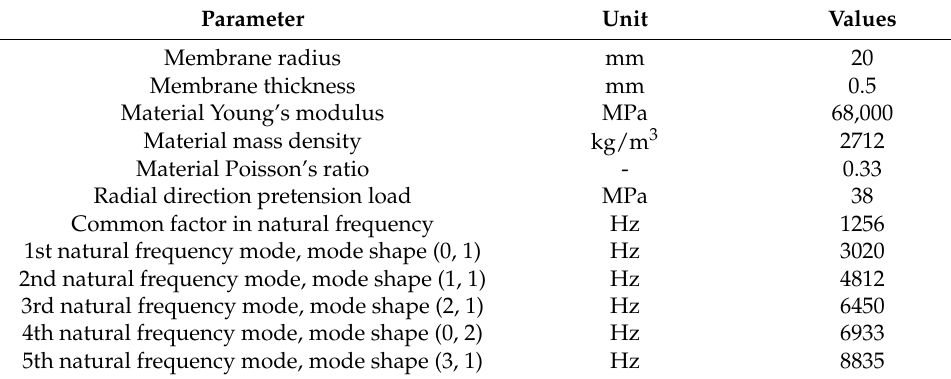
Table 1. Models’ parameters of vibration